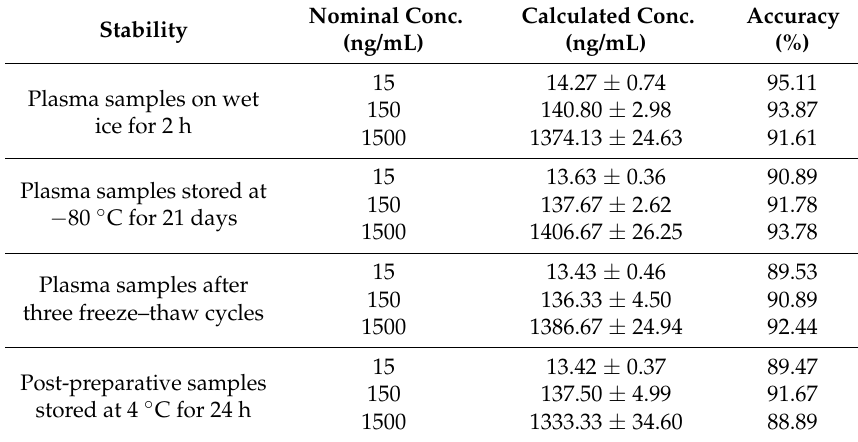
Table 3. Summary of kinsenoside stability in beagle dog plasma under various storage conditions ( n =